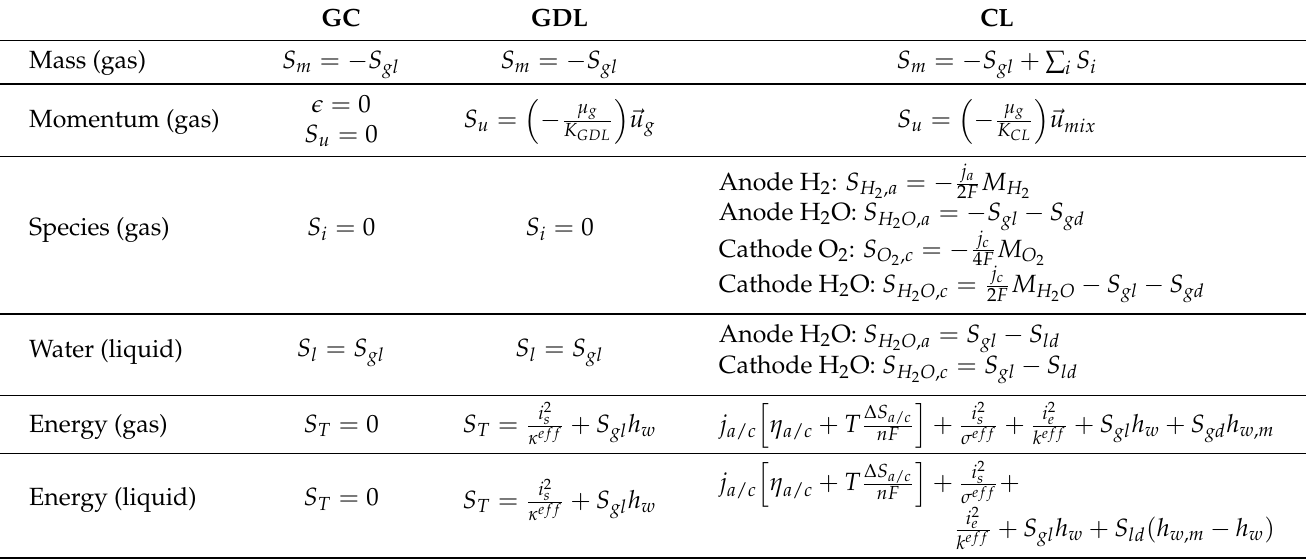
Table 4. Source terms for the eulerian multi-phase (EMP) governing equations from the works in [5,24]. GC GDL